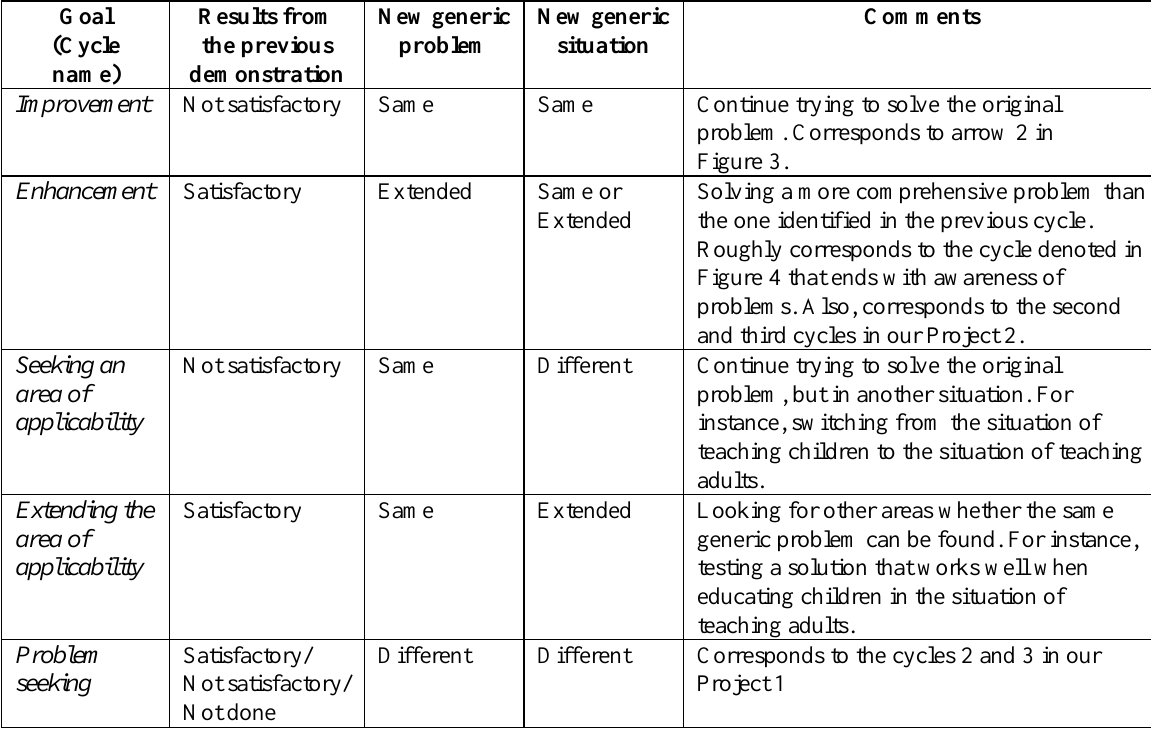
Table 2. A preliminary classification of DS